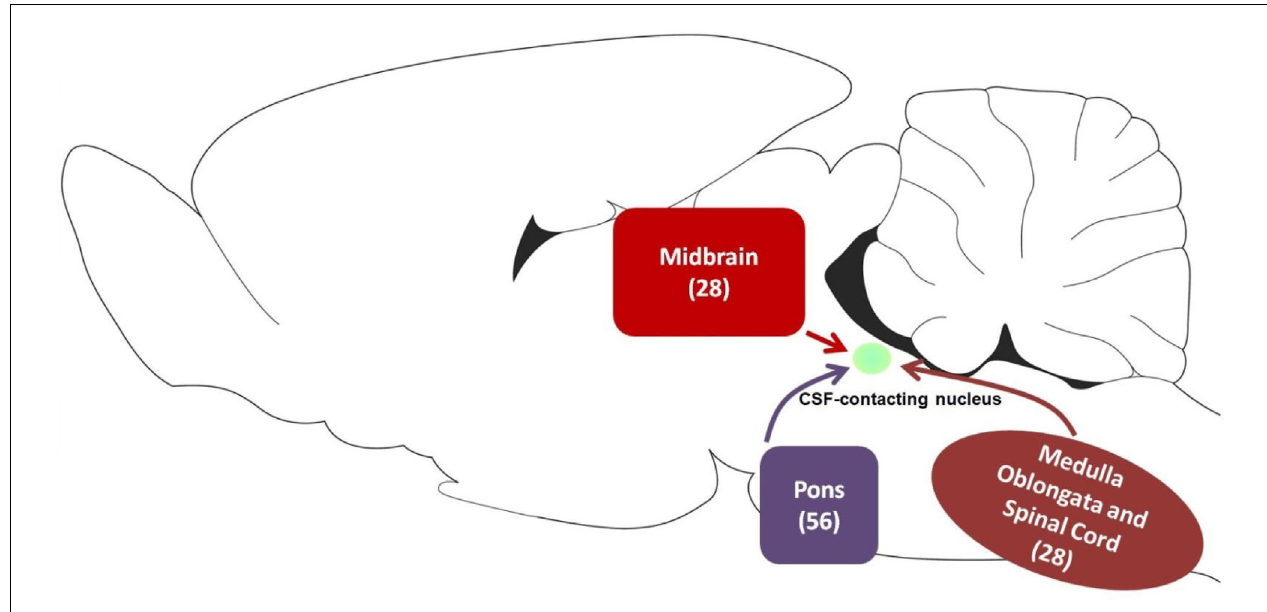
FIGURE 14 | The schematic diagram of projections from functional areas in the brainstem and spinal cord to the CSF-contacting nucleus. Among them, midbrain contains 28 sub-regions, pons contains 56 sub-regions, and medulla oblongata and spinal cord contain 28